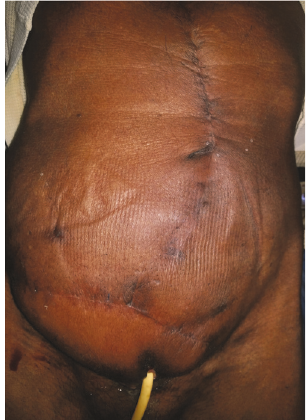
Figure 7: Healed wound at 6 months of